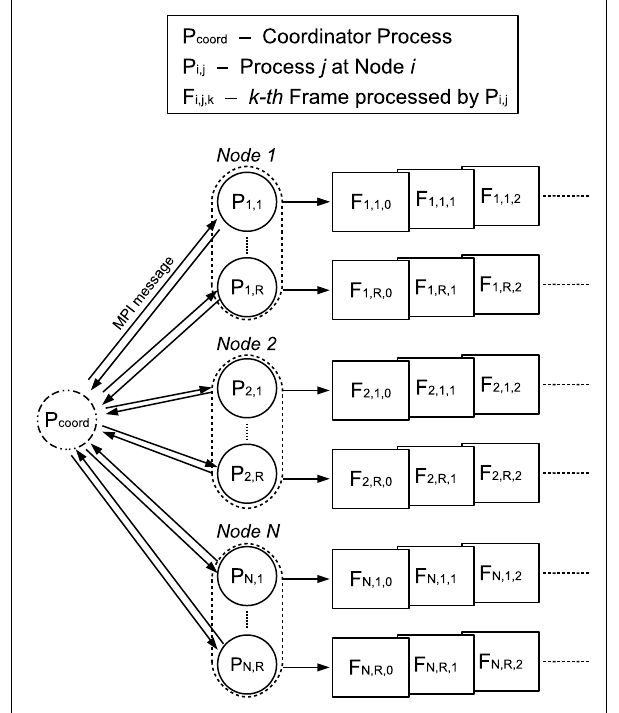
Figure 8. DMG-AI parallel